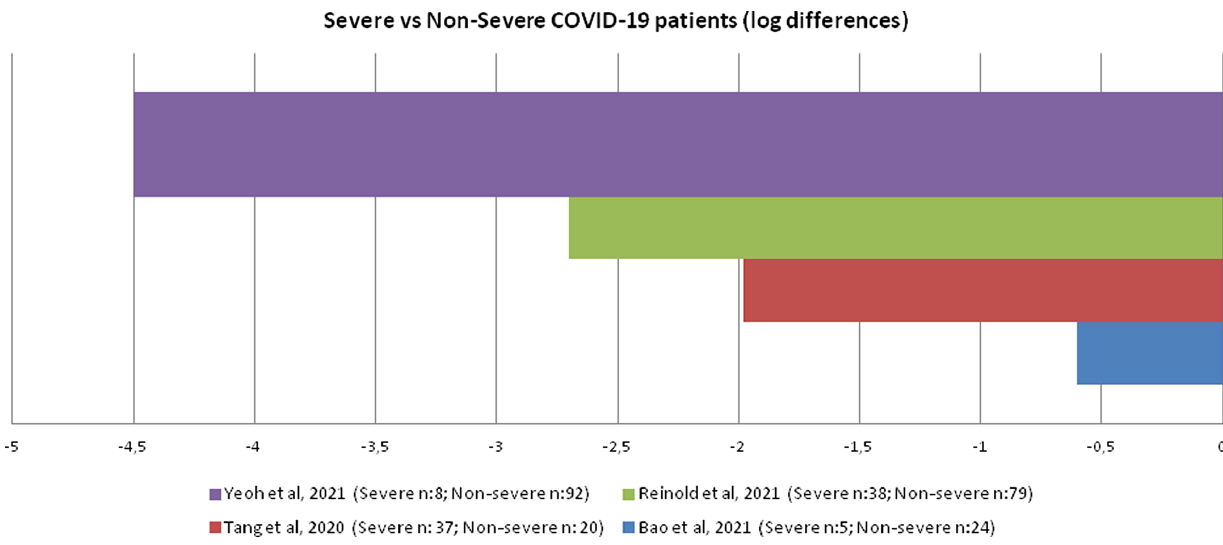
Figure 1. Comparison of Faecalibacterium prausnitzii in the gut microbiota reported in severe COVID-19 patients with those in non-severe COVID-19 patients. COVID-19, coronavirus disease